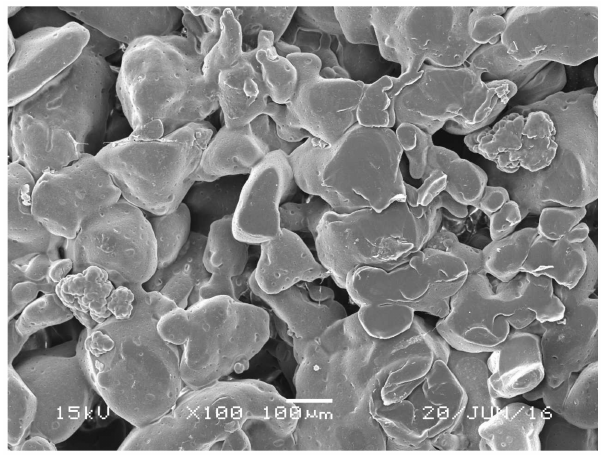
Figure 1. Scanning electron microscopic images of the porous polyethylene. Surface scale bar = 100 µ